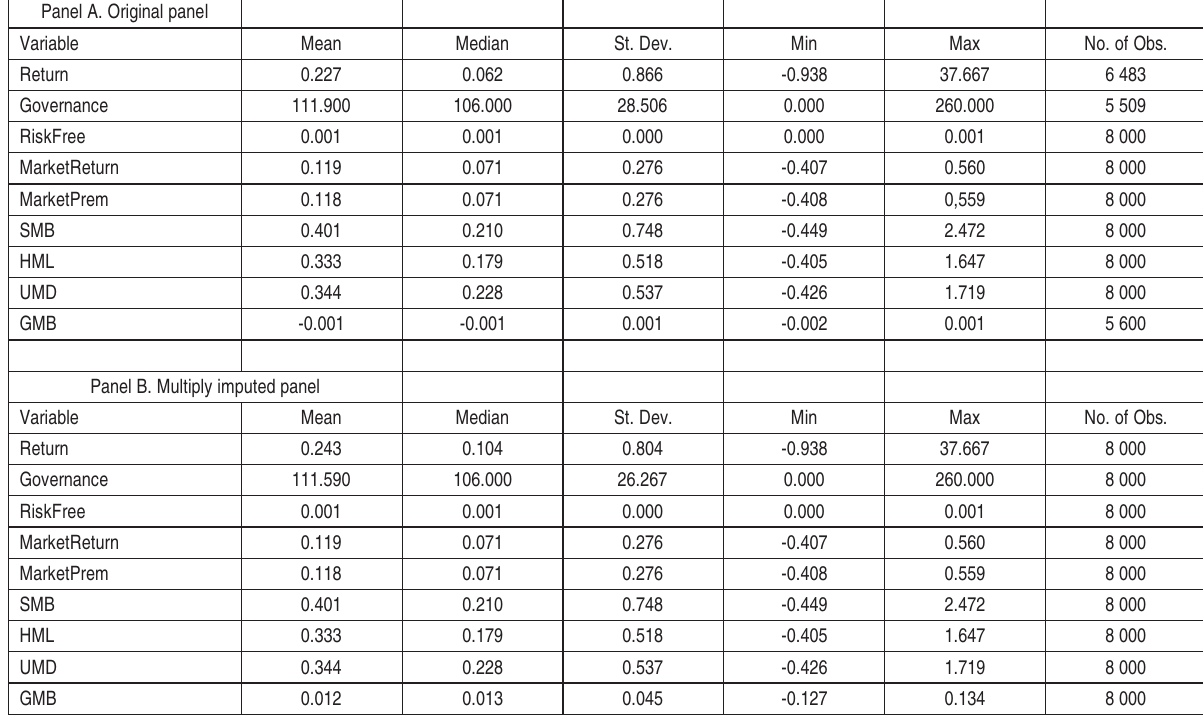
Table 1. Representative statistics